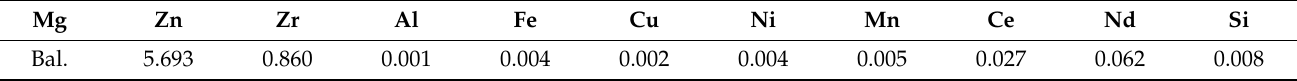
Table 1. Chemical composition of the investigated alloy (in wt.